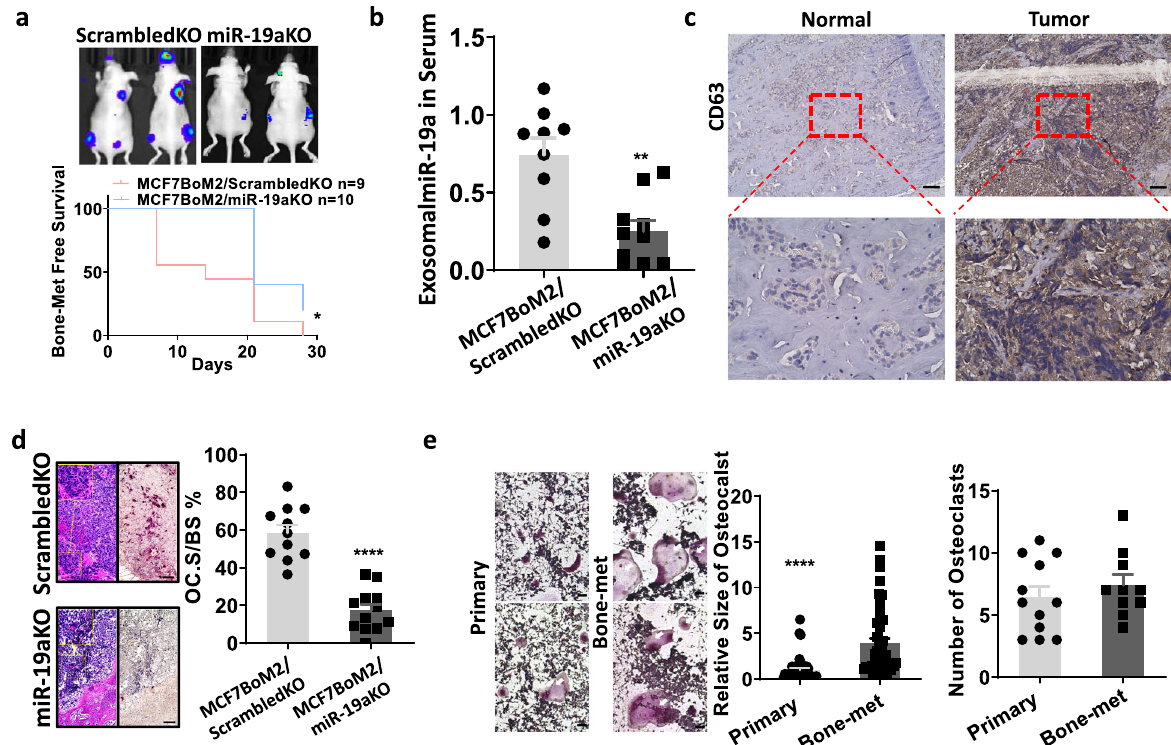
Fig. 3 miR-19a promotes osteolytic bone metastasis. a MCF7BoM2/ScrambledKO and MCF7BoM2/miR-19aKO were transplanted into female nude mice via intracardiac injection. The growth of bone metastasis was monitored by measuring the luciferase activity by IVIS Bioimager. Log-rank (Mantel – Cox) test was performed to calculate the p -value ( p = 0.0109). b At the endpoint (day 28), mice were sacri fi ced and the expression of exosomal miR-19a from serum was examined by Taqman. A two-sided student ’ s t -test was performed ( p = 0.0011, n = 9 vs 10). Data are presented as mean values±SEM. c Representative fi gures of the expression of exosomal marker CD63 in normal bone and tumor-bearing bone from the mice. Scale bar, 100 µ m. d TRAP staining for osteoclast cells in tumor-bearing bones from the mice transplanted with MCF7BoM2/ScrambledKO or MCF7BoM2/miR-19aKO. OC surface relative to the bone surface was calculated and compared. H&E staining of the same fi eld was shown together with the TRAP staining. Scale bar, 100 µ m. A two-sided student ’ s t -test was performed ( p = 0.00000014, n = 11 vs 12). Data are presented as mean values±SEM. e Exosomes from the serum of ER + breast cancer patients with ( n = 10) or without ( n = 12) bone metastasis were isolated. The harvested exosomes were incubated with mouse bone marrow-derived monocytes. After 1 week, the cells were fi xed and TRAP staining was performed. The size ( p = 0.0000039) and number ( p = 0.4254) of differentiated OC were quanti fi ed and compared. Scale bar, 100 µ m. Two-sided student ’ s t -tests were performed. Data are presented as mean